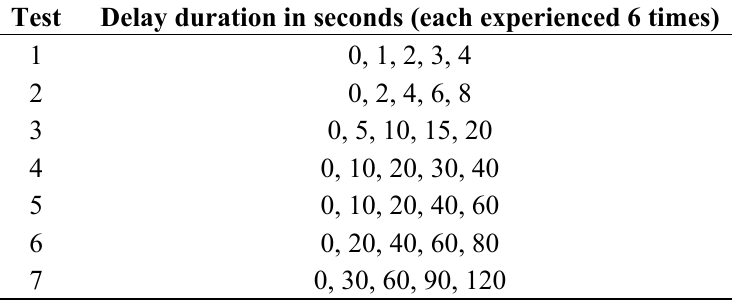
Table 1. Duration of delay (seconds) before reinforcer was delivered on each